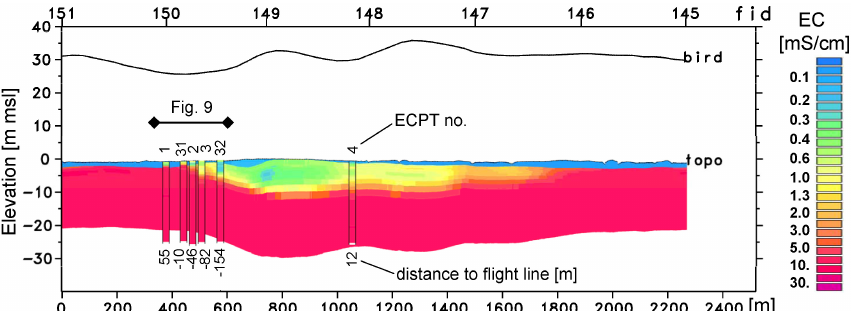
Fig. 13. Cross-section showing the electrical conductivity of smooth 15-layer HEM inversion models along a west-east flight line and nearby ECPT measurements (for location see Fig. 14).